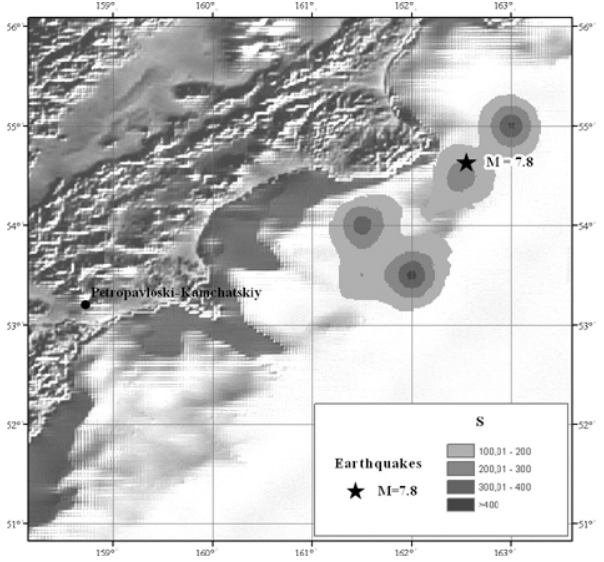
Fig. 6. Areas of foreshock activation before the Kronotskoe earthquake. The star marks the main shock M = 7 . 8.